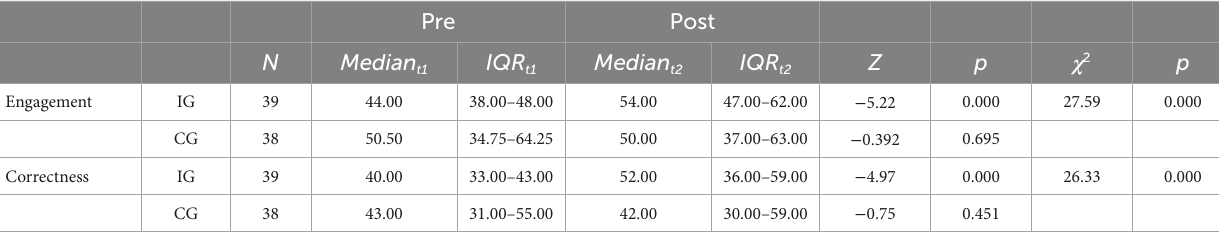
TABLE 2 Overview over nonparametric